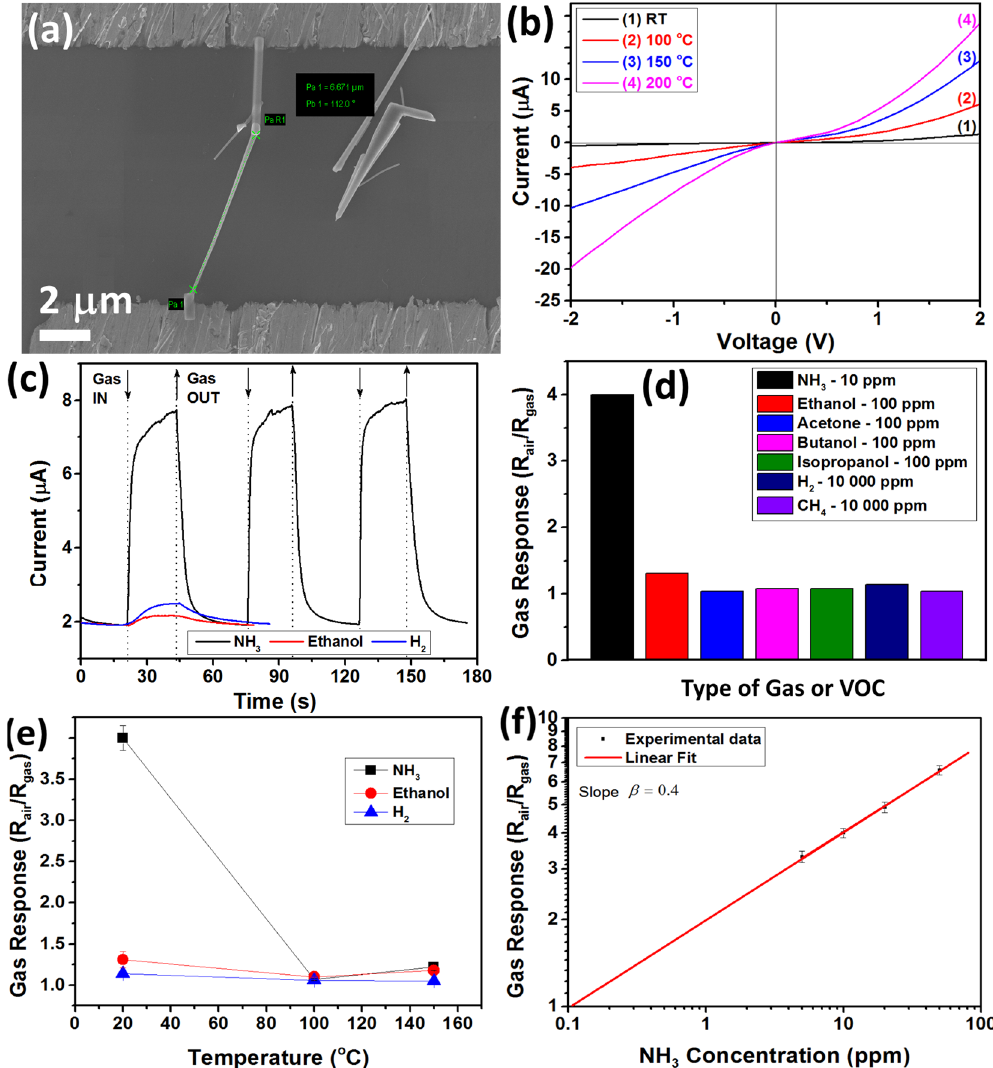
Figure 5. ( a ) SEM image of the nanosensor based on individual ZnO-CNT NW with D = 100 nm (from sample with 2.0 wt% CNT). ( b ) Current – Voltage characteristics of the nanosensor at different operating temperatures. ( c ) Dynamic gas response of the nanosensor at room temperature and applied bias voltage of 2 V to 10 ppm of NH 3 , 100 ppm of ethanol and 10 000 ppm of H 2 gas. ( d ) Gas response to different gases and VOCs at room temperature. ( e ) Gas response to 10 ppm of NH 3 , 100 ppm of ethanol and 10 000 ppm of H 2 gas versus operating temperature. ( f ) Gas response of nanosensor at room temperature versus concentration of NH 3